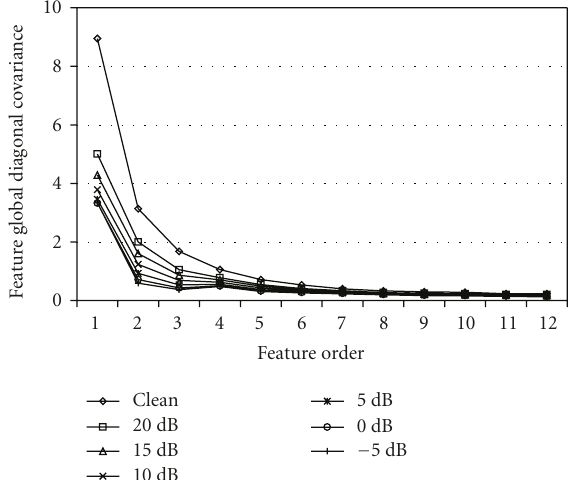
Figure 3: Changes in feature variance with various SNR conditions.